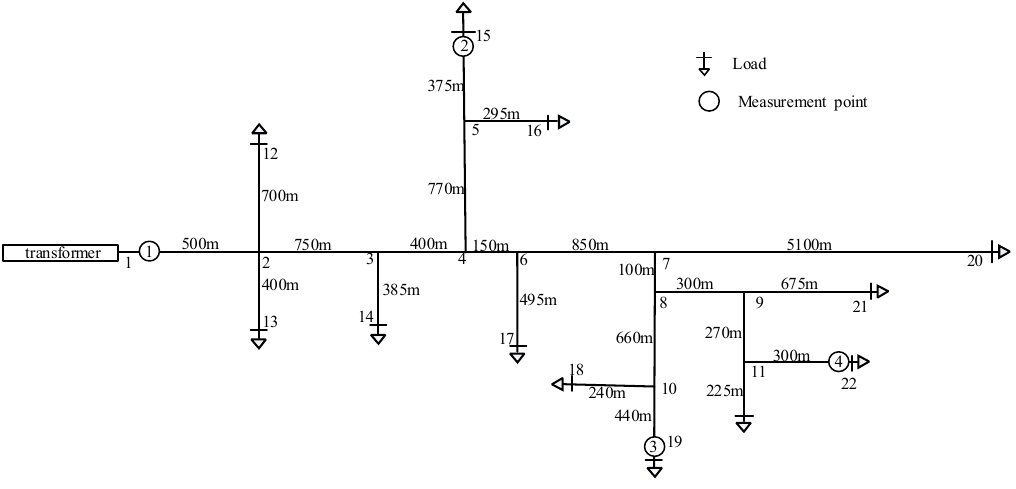
Figure 8. Topology of a real 10 kV distribution network.